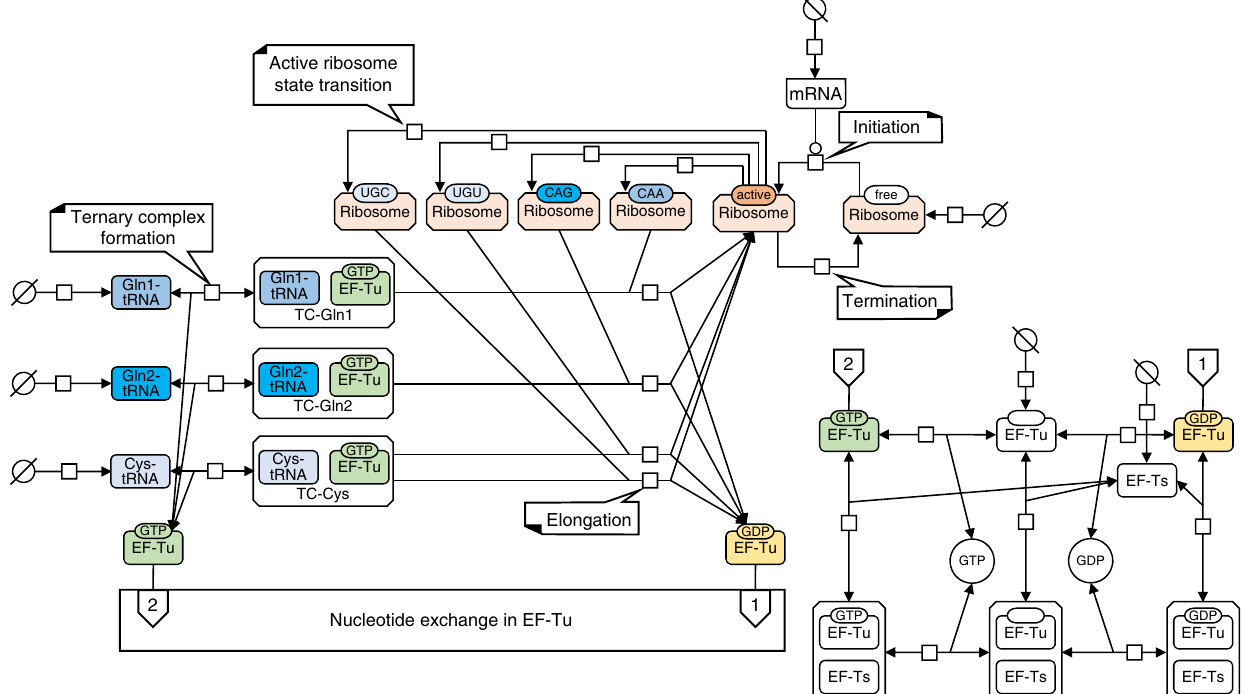
Fig. 1 Schematic overview of the translation model. A reduced pathway for elongation with amino acids cysteine (aminoacyl-tRNA Cys) and glutamine (aa-tRNA Gln1, Gln2) is represented in Systems Biology Graphical Notation. Initiation: free (unbound) ribosome gets converted to active ribosome, modulated by mRNA. Termination: active ribosome converts back to free ribosome at a rate fi xed by the desired protein production rate. Active ribosome state transition: active ribosome instantaneously binds to codons (61 codons in full model, 4 here) at the fractions set by the speci fi ed proteome composition. Ternary complex formation: charged tRNAs (40 aa-tRNAs in full model, 3 here), replenished from a pool, combine with EF-Tu*GTP to form ternary complexes (40 TCs in the full model). Kinetic parameters of these reversible processes depend on the aa-tRNA. Elongation: labeled ribosome